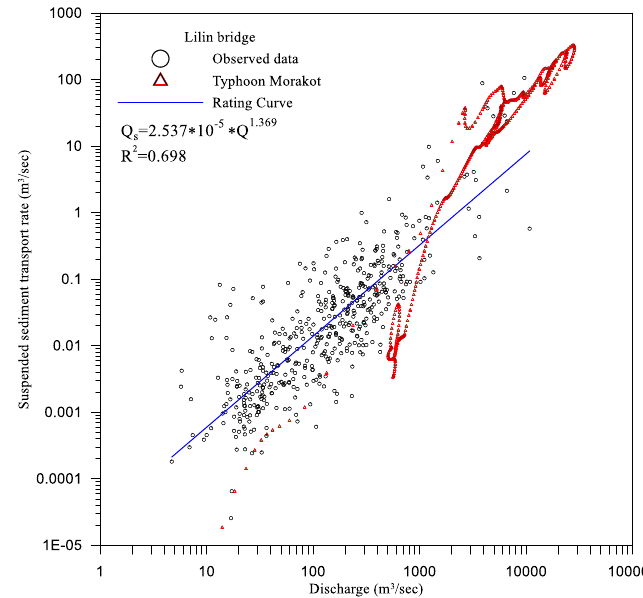
Figure 15. Simulated and observed relationship between flow discharge and sediment transport rate at Lilin Bridge station.